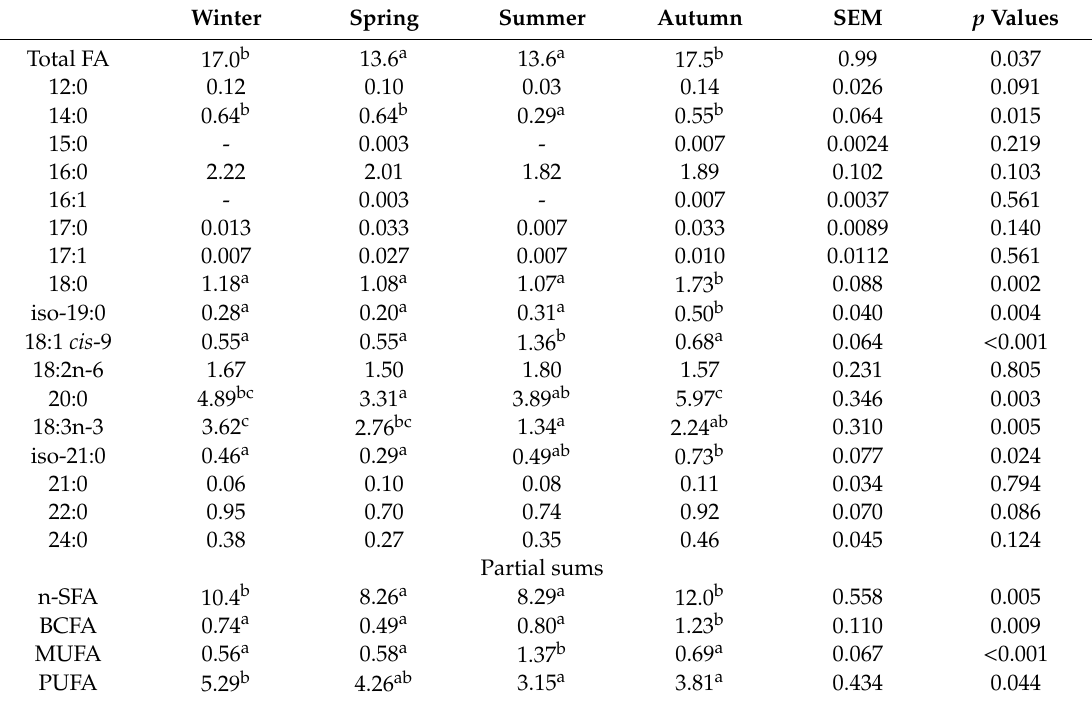
Table 1. E ff ect of season on fatty acid composition (mg / g DM) of C. ladanifer leaves. Winter Spring Summer